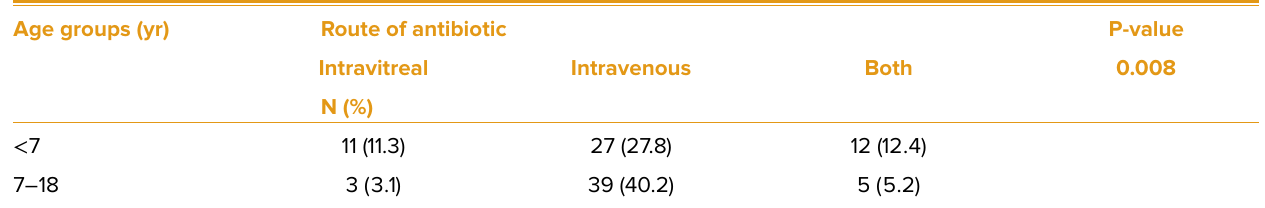
Table 7. Route of antibiotic injection by age